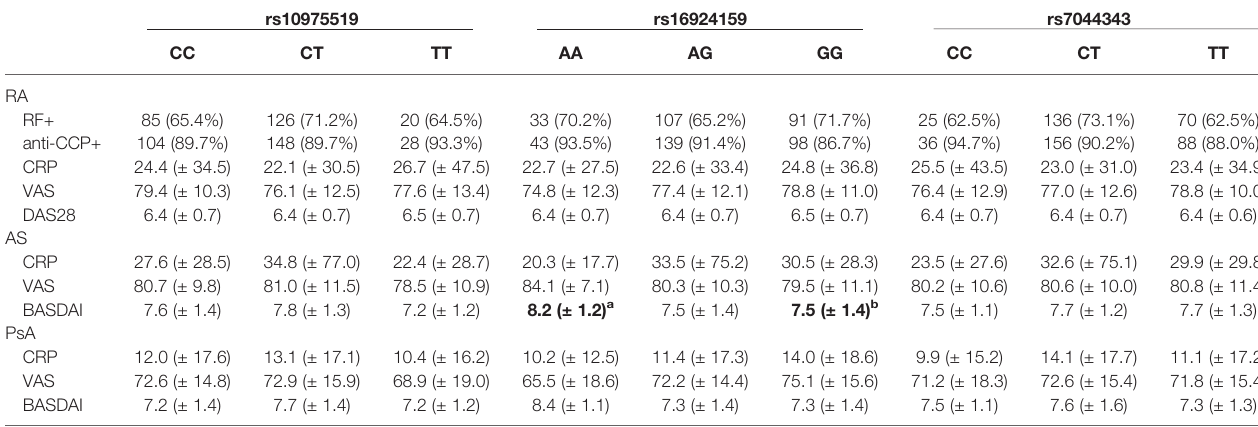
TABLE 5 | Analysis of the IL-33 genotypes distributions with regard to baseline clinical parameters of rheumatoid arthritis, ankylosing spondylitis and psoriatic arthritis patients.